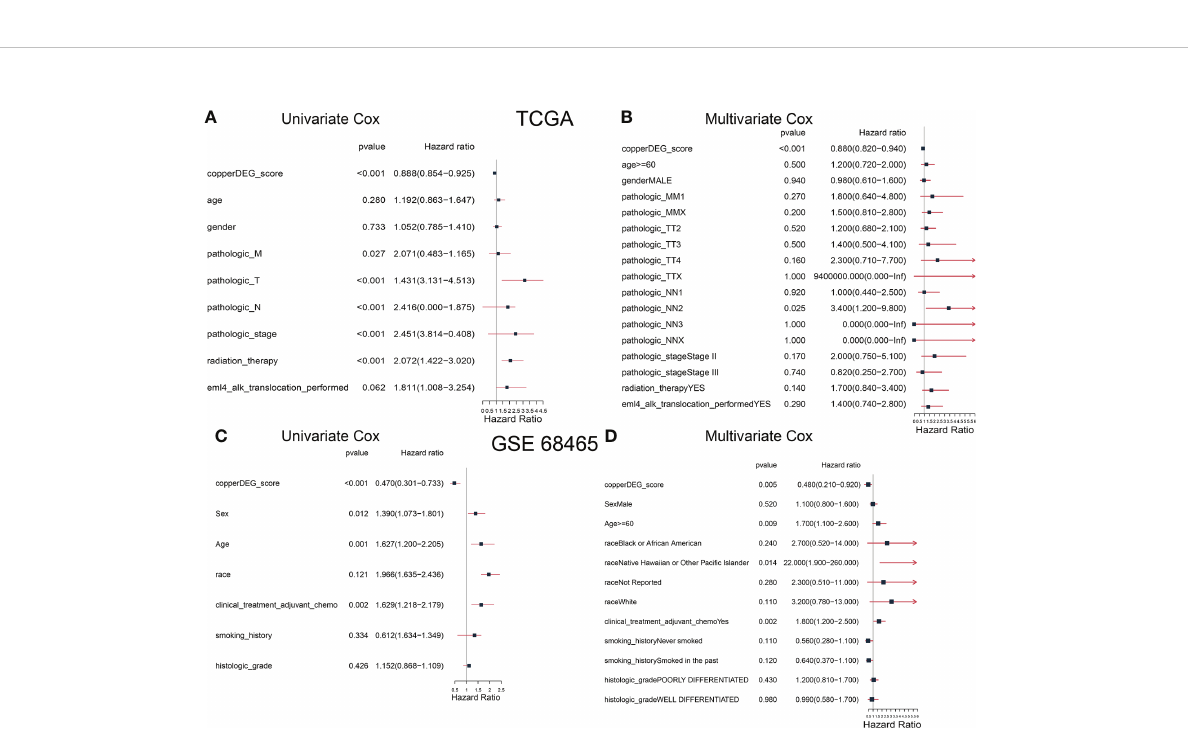
FIGURE 6 The correlation and independent prognosis analysis of CSS value and clinicopathological variables in LUAD. Univariable analyses showed the prognostic value of the CSS in the training (A) and testing (C) set. Multivariable analyses showed the prognostic value of the CSS in the training (B) and testing (D) set. CSS, cuproptosis scoring system; LUAD, lung